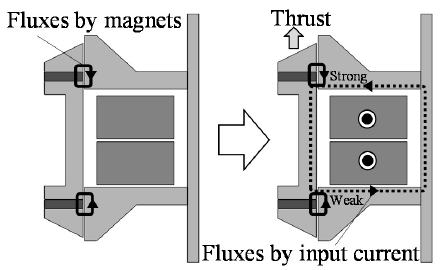
Figure 5. Operational principle in series.